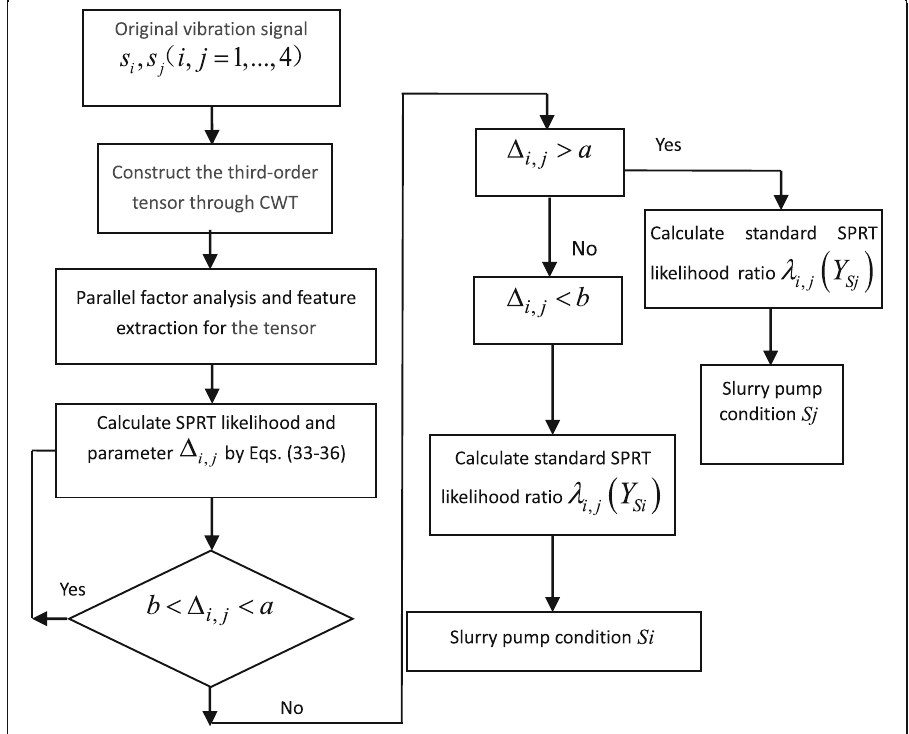
Fig. 22 Diagnostic process based on binary SPRT for centrifugal